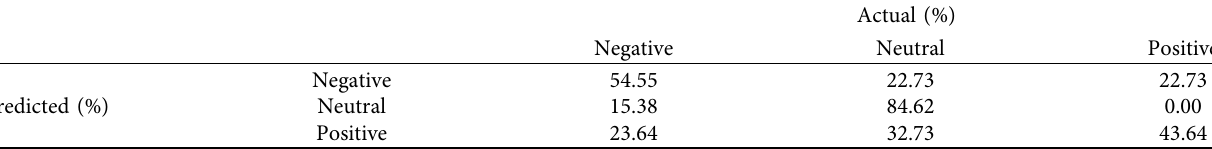
Table 3: Confusion matrix of the random forest model.